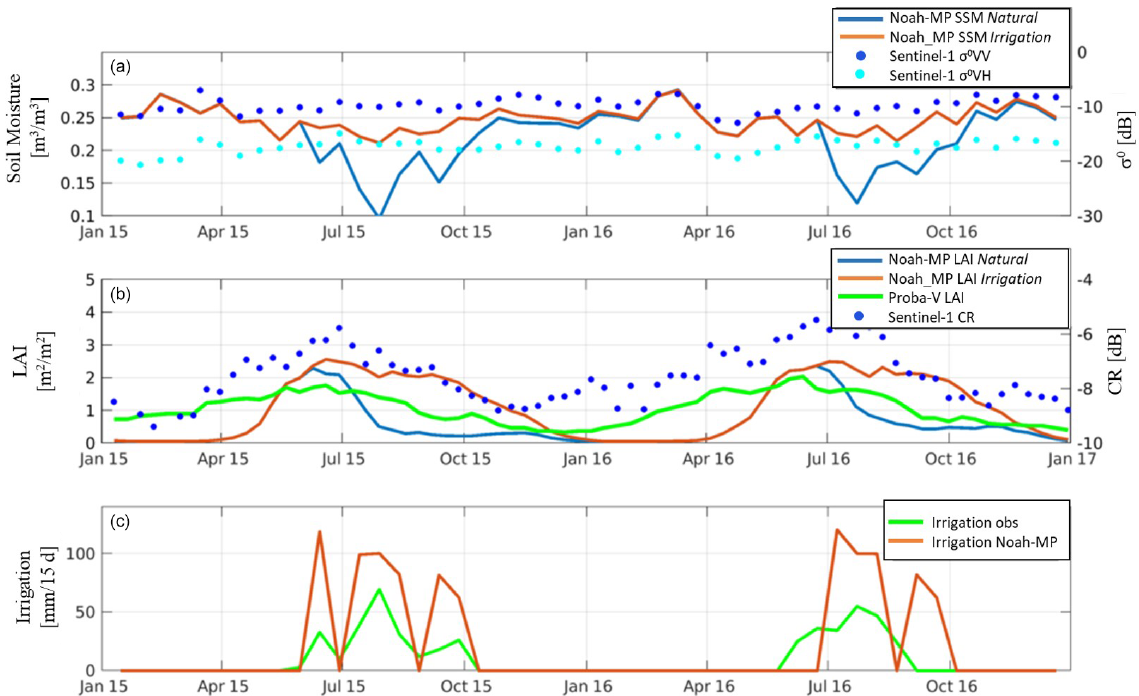
Figure 7. Sentinel-1 σ 0 VV and σ 0 VH data for the Budrio field 1 test site compared with Noah-MP SSM, for (a) natural and irrigation runs. Sentinel-1 CR (VH/VV) compared with PROBA-V LAI and Noah-MP LAI for (b) natural and irrigation runs. Also shown are the (c) observed irrigation (green) and simulated irrigation from Noah-MP